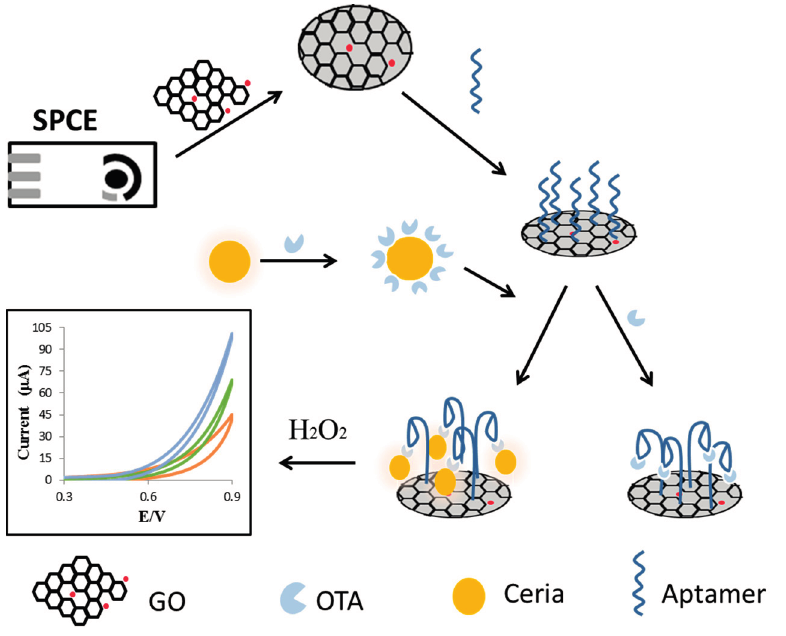
Figure 3. Non-enzymatic electrochemical aptasensor based on the use of a nanoceria tag and graphene oxide (GO) on a screen-printed electrode (SPCE) for the detection of ochratoxin A (OTA) (reproduced from [50] with permission of The Royal Society of